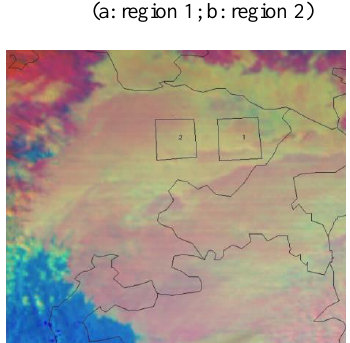
Figure 13. T-Re profiles at 14:30 LST (a: region 1; b: region 2)